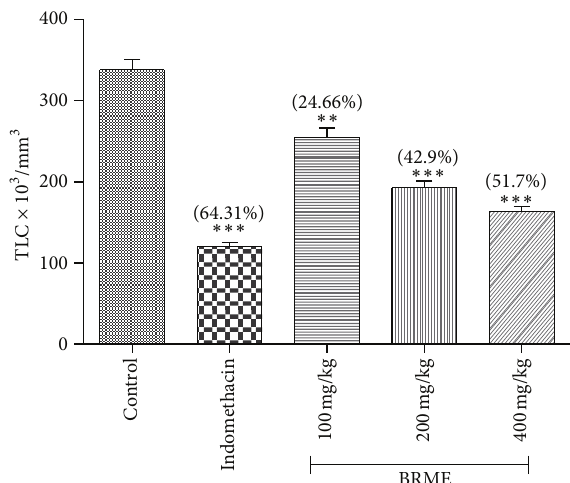
Figure 7: Effect of the BRME and indomethacin on % MPO inhibition. Each value represents the mean ± SEM ( 𝑛 = 6 ). Experimental groups were compared to control, ∗ 𝑃 < 0.05 , ∗∗ 𝑃 < 0.01 (one-way ANOVA followed by Dennett’s